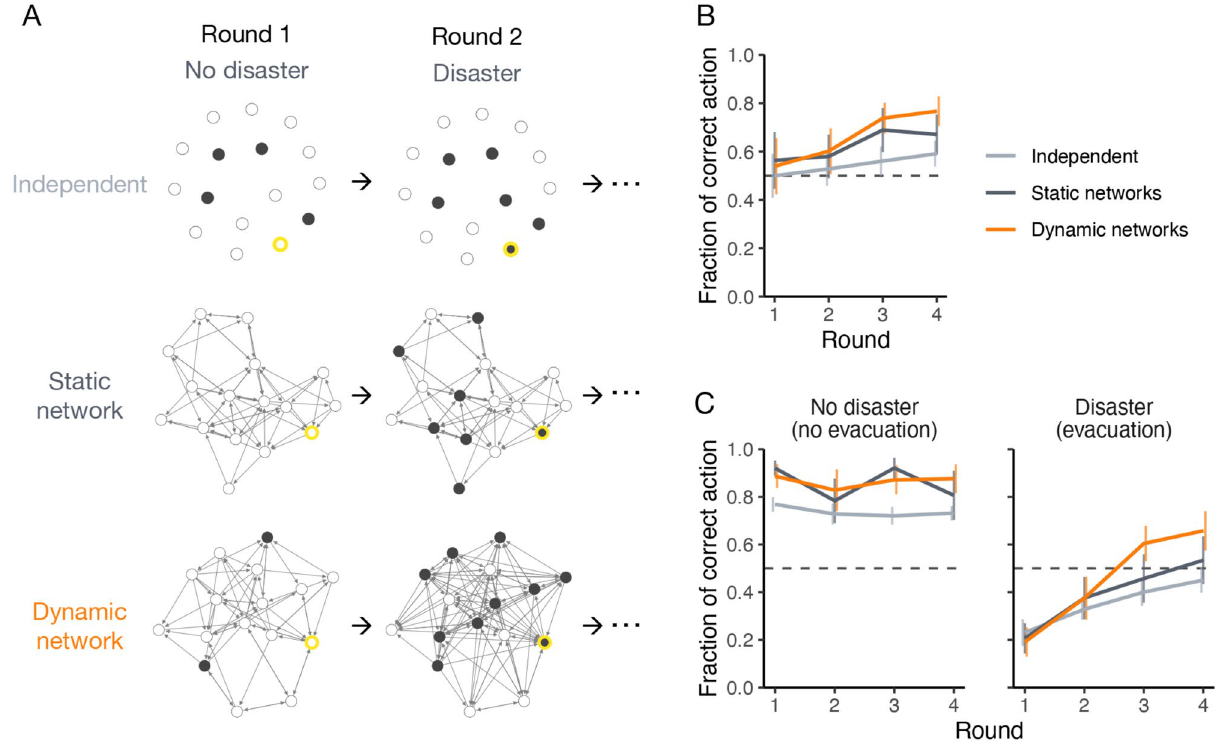
Figure 1. Network condition and collective performance across rounds. ( A ) The states of the first two rounds in three out of 180 sessions. Open nodes indicate players staying to the round’s end; filled ones indicate players evacuating before it. Yellow outline frame indicates informants (who know the truth in advance). Players could update their connections between rounds in the dynamic network condition. ( B ) Overall behavioral accuracy across rounds. Lines indicate average fractions of subjects who select an appropriate behavior at the game end (i.e., stay without “disaster” or evacuate with “disaster”) across rounds with and without a network ( n = 40 for each condition). The dashed line is 50% of accuracy that indicates the same level as a random binary choice. Error bars are 95% confidence intervals among sessions. ( C ) The changes in behavioral accuracy are highlighted by the presence or absence of “disaster” ( n = 20 for each